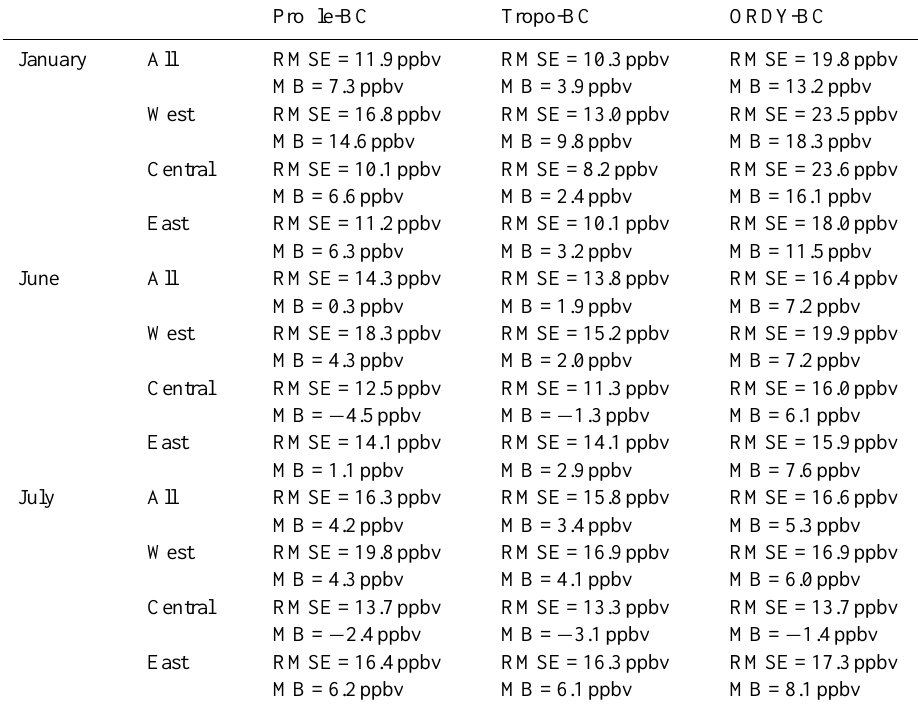
Table 3. Summary of NET-RMSE and average column temperatures for the sonde sites.